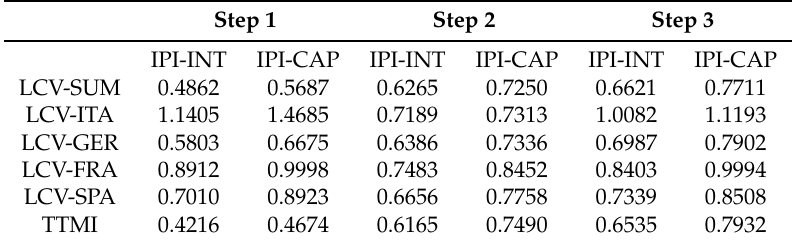
Table A22. Comparison of root mean squared error with expanding window applied to conditional var with three variables. The forecast windows expands itself from 2008:01 to 2018:12. The ratio between RMSEs is showed. A value less than one shows an improvement over benchmark.